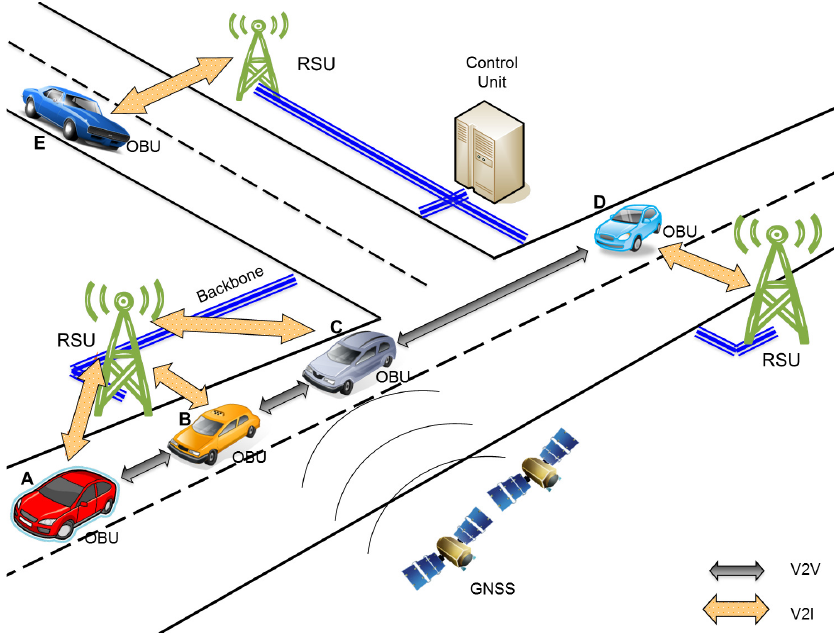
Figure 1. Combined V2V and vehicle-to-infrastructure (V2I) communication (V2X)-based vehicular density estimation